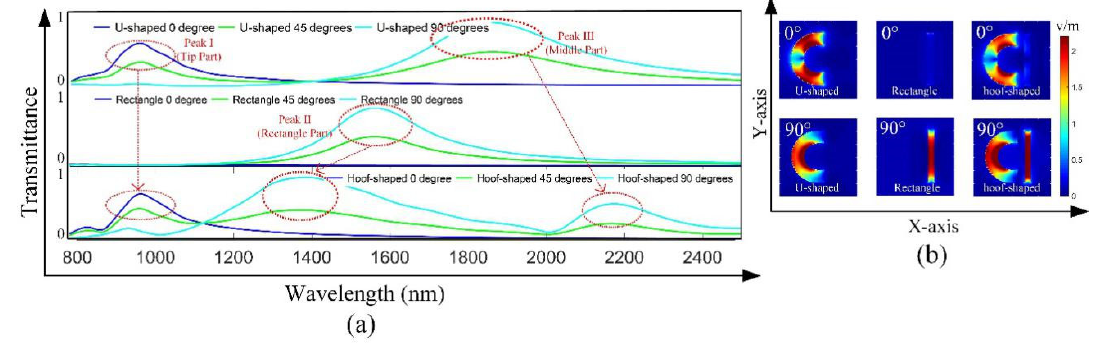
Figure 3. ( a ) Transmittance spectrums of the three structures (U-shaped, rectangle and hoof-shaped) under the different angles of the incident polarization, the structural parameters of the three structures remain unchanged. ( b ) Electric field distributions of U-shaped structure, rectangle structure and hoof-shaped structure at 0 and 90 degrees.